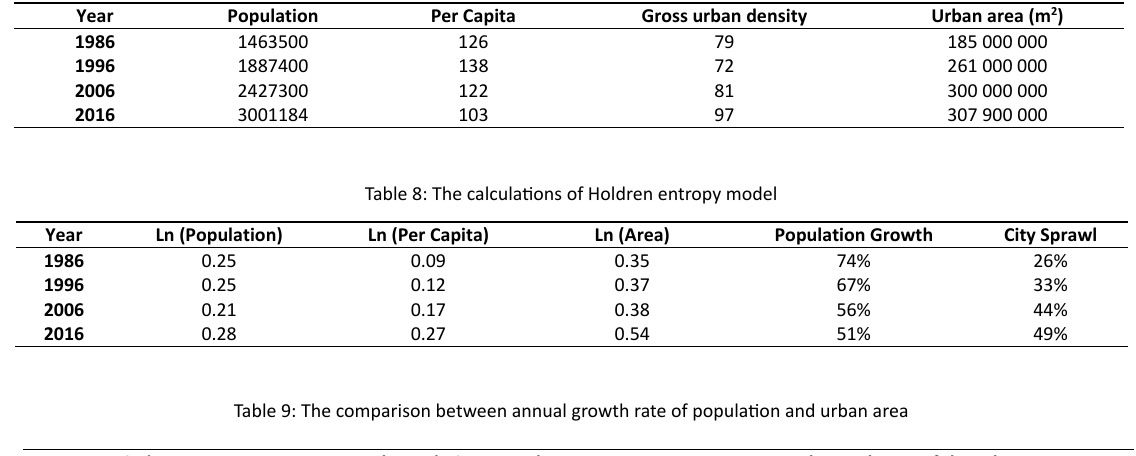
Table 7: Basic statistics of Holdren entropy model